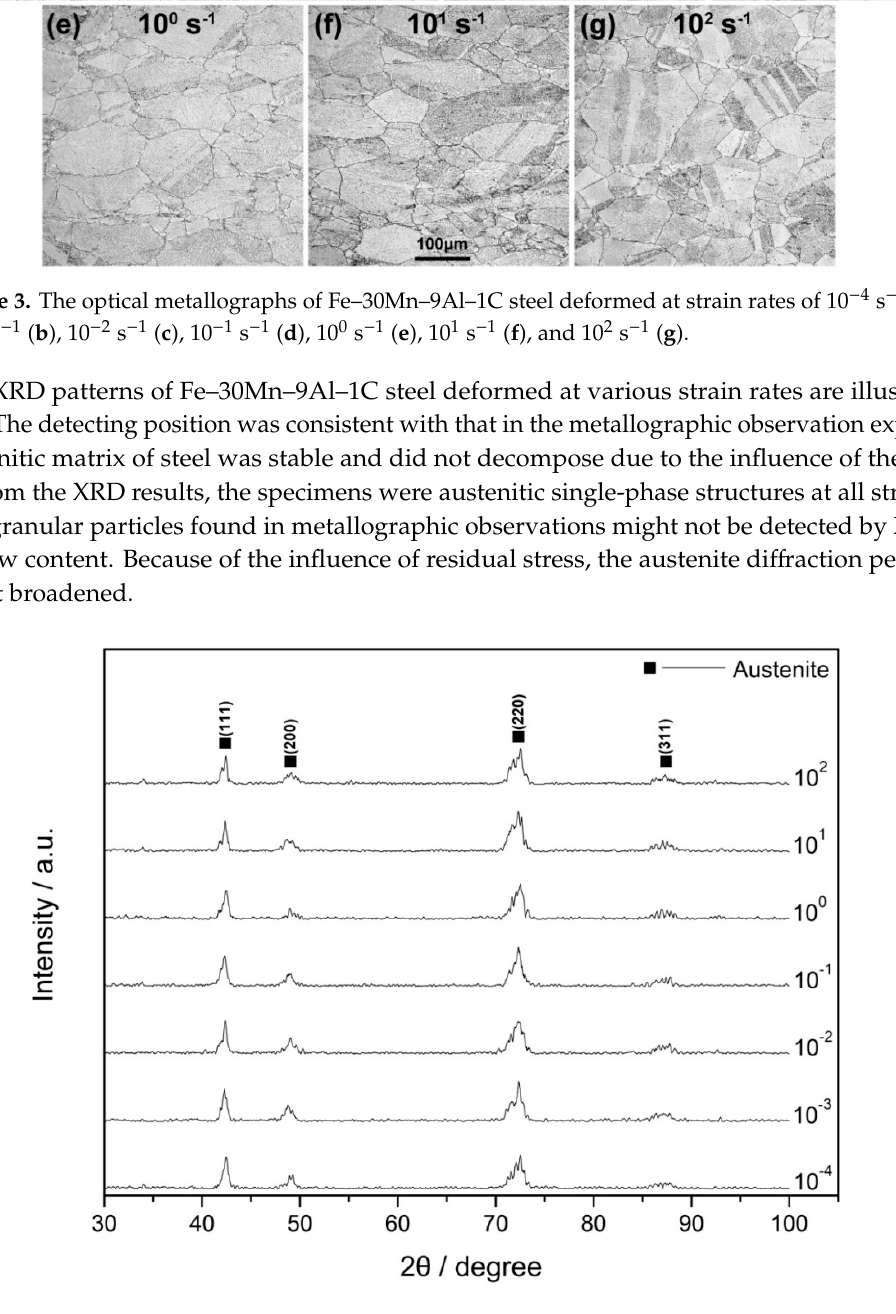
Figure 4. X-ray diffraction patterns of Fe–30Mn–9Al–1C steel deformed at various strain rates.